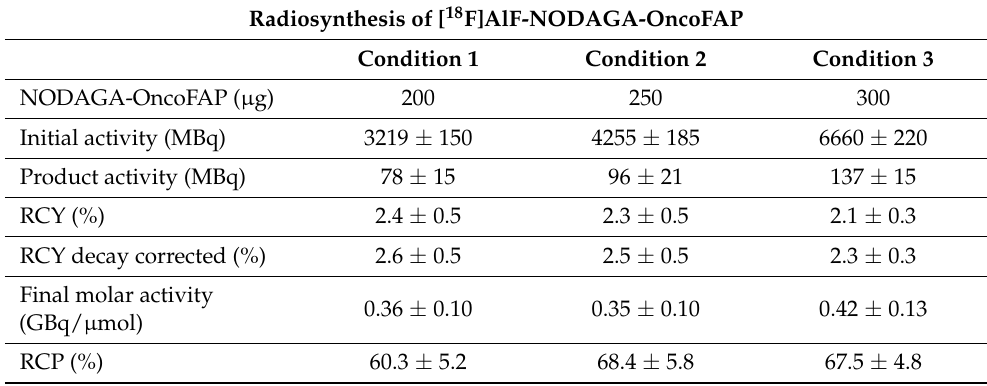
Table 8. Different conditions used for the synthesis of [ 18 F]AlF-NODAGA-OncoFAP.